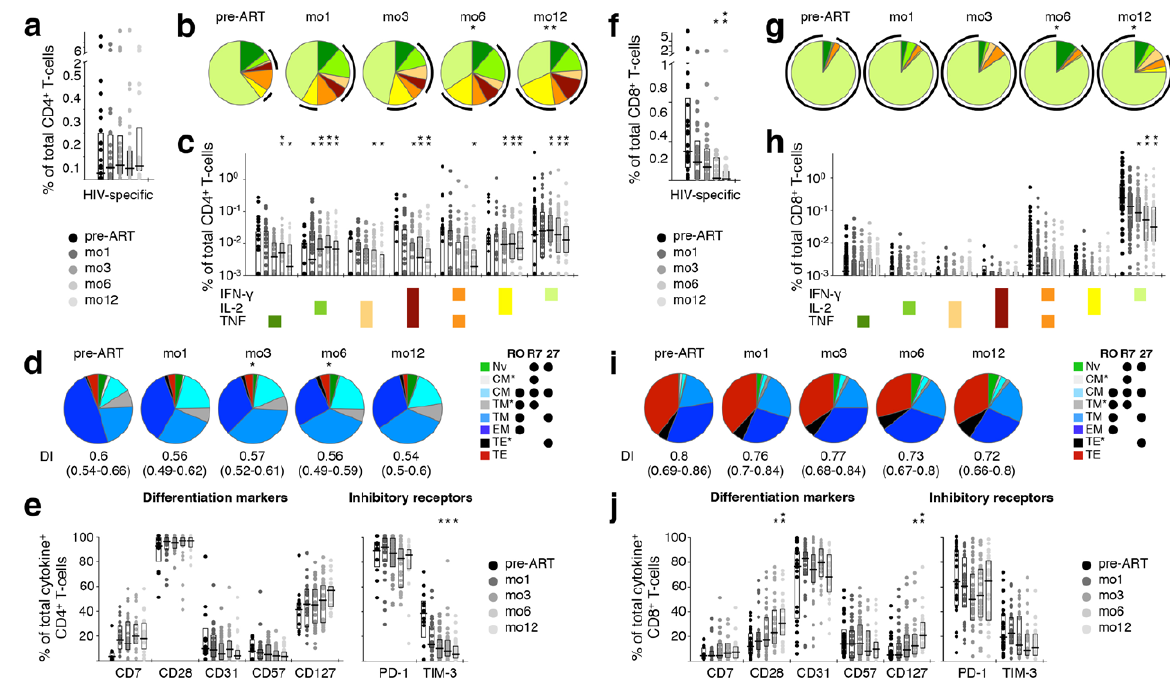
Figure 1. Longitudinal analysis of HIV-1 Gag-specific cytokine production by T cells and the phenotype of cytokine-producing cells. The effect of ART on HIV-1 Gag-reactive CD4 + (A-E) and CD8 + T cells (F-J) was determined in longitudinal PBMC samples of HIV-1 + patients. (A, F) Total response magnitude, mea- sured by production of IFN-γ, IL-2, or TNF. (B, G) Cytokine pattern. Relative proportion of total HIV-1 Gag-reactive cells producing each possible combination of the cytokines measured. Black arcs indicate all IL-2 (B) or IFN-γ (G) producing cells. (C, H) Actual frequency of cells producing only IFN-γ, IL-2, or TNF, or any combination thereof. Potential phenotypic alterations occurring due to ART were explored in HIV-1 Gag-reactive CD4 + (D, E) and CD8 + T cells (I, J) in longitudinal PBMC samples of HIV-1 + patients. (D, I) Differentiation state. T-cell differentiation subsets of cytokine-positive cells were defined by expression of CD45RO (“RO”), CCR7 (“R7”), and CD27 (“27”). Differentiation indices (DI; medians and interquartile ranges) are indicated below each pie. (E, J) Phenotype. The frequency of cytokine-pos- itive cells expressing differentiation markers (CD7, CD28, CD31, CD57, CD127) or inhibitory receptors (PD-1, TIM-3) was determined. Graphs show interquartile ranges, median bars, as well as individual data points. All time-points were compared to corresponding pre-ART measurements: * P <0 .01, ** P < 0 .001, *** P < 0